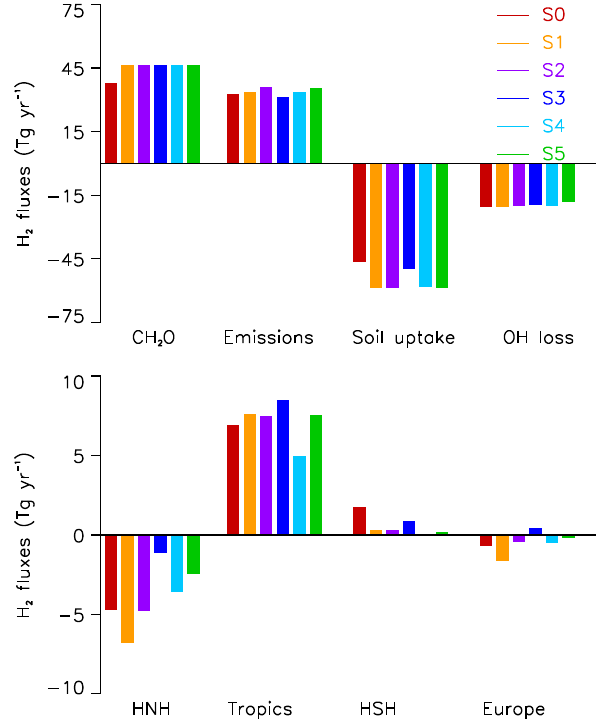
Fig. 7. Posterior H 2 budget per process (above) and regions (below). Each colour bar represents a scenario.